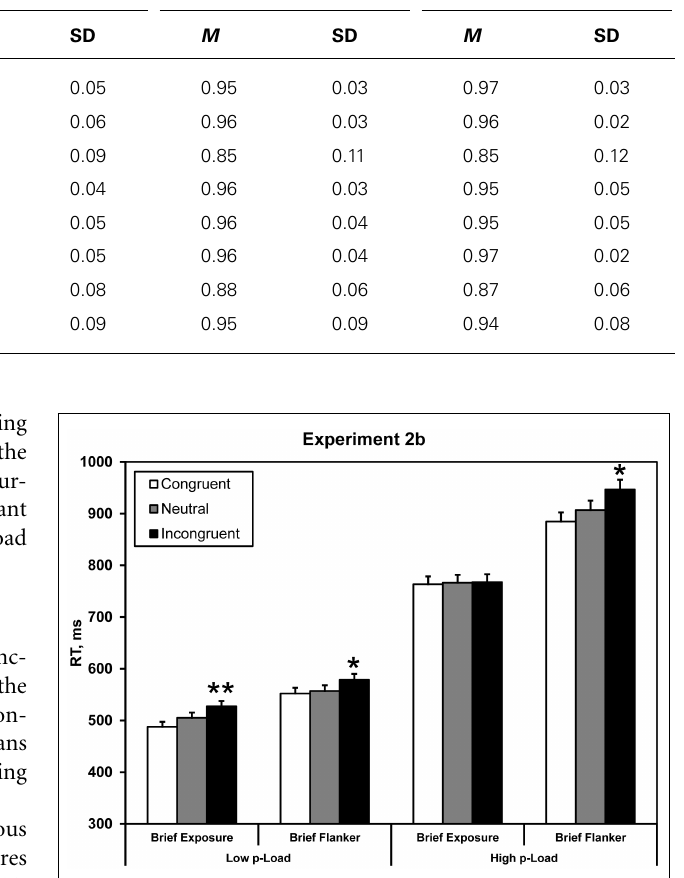
FIGURE 5 | Mean correct RT in Experiment 2b. Briefly exposed stimuli were presented for 100 ms – all other stimuli were response-terminated. Asterisks denote significance from neutral condition: * p < 0.05, ** p < 0.01. Error bars represent 95% within-observers confidence intervals (Loftus and Masson, 1994; Morey,